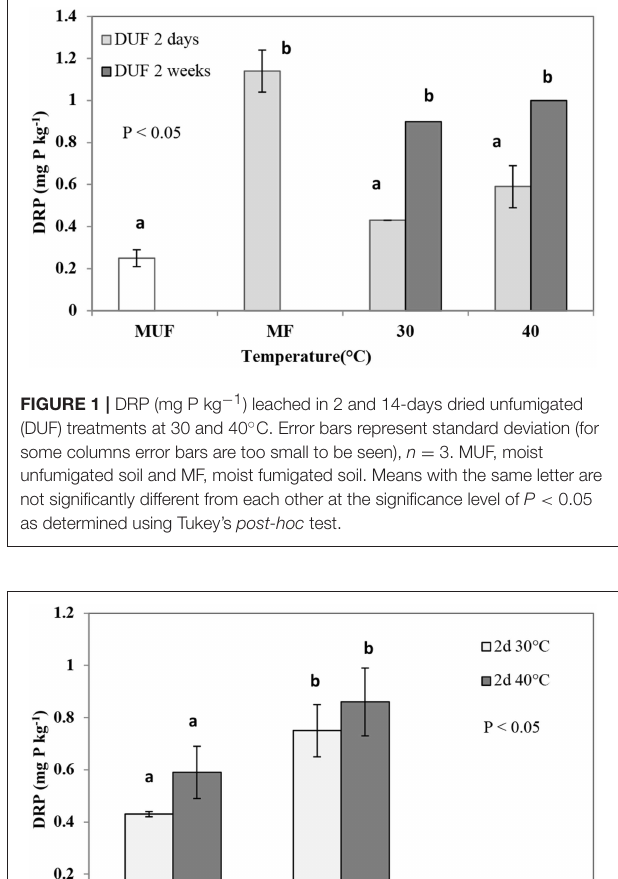
( Figure 2 ), relative to 2-days dried unfumigated controls